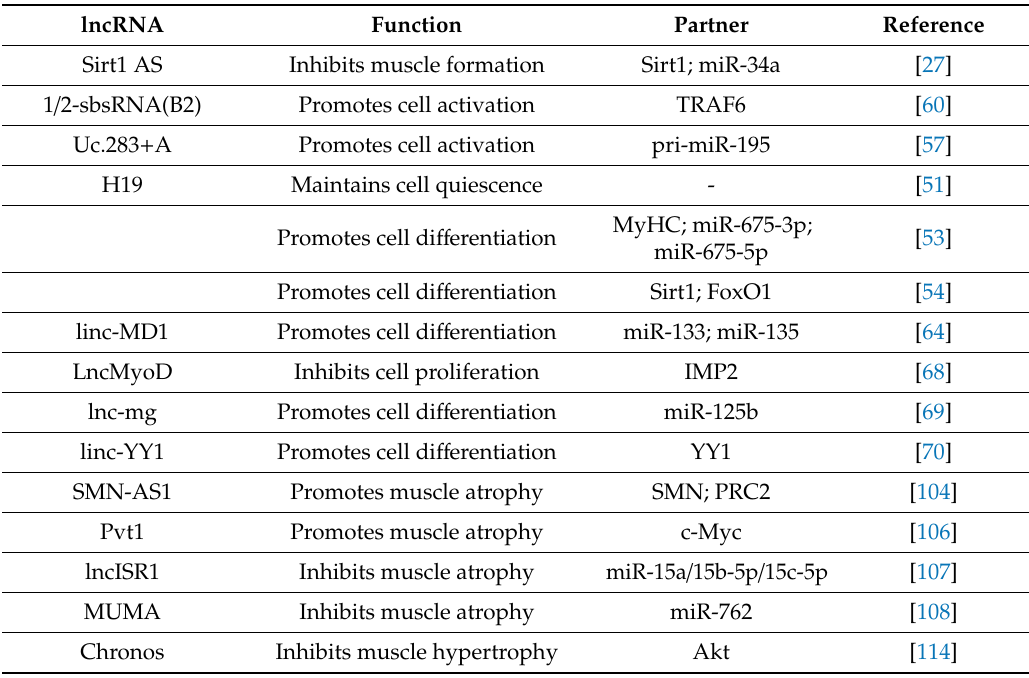
Table 2. Long non-coding RNAs (lncRNAs) in the myogenesis of skeletal muscle satellite cells. lncRNA Function